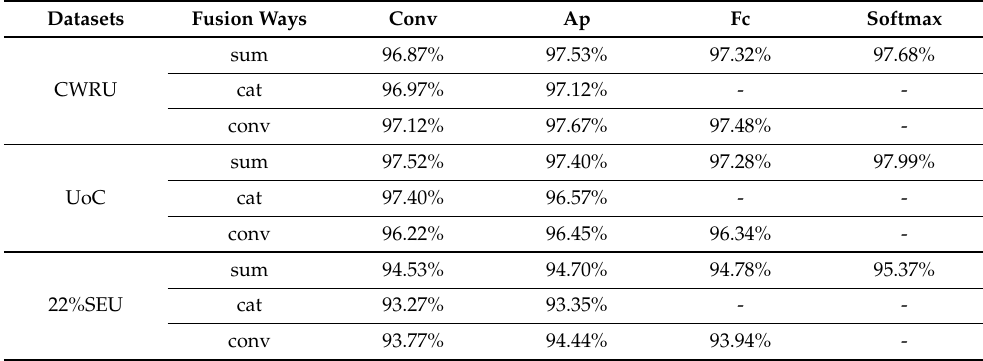
Table 13. Performance comparison of different fusion